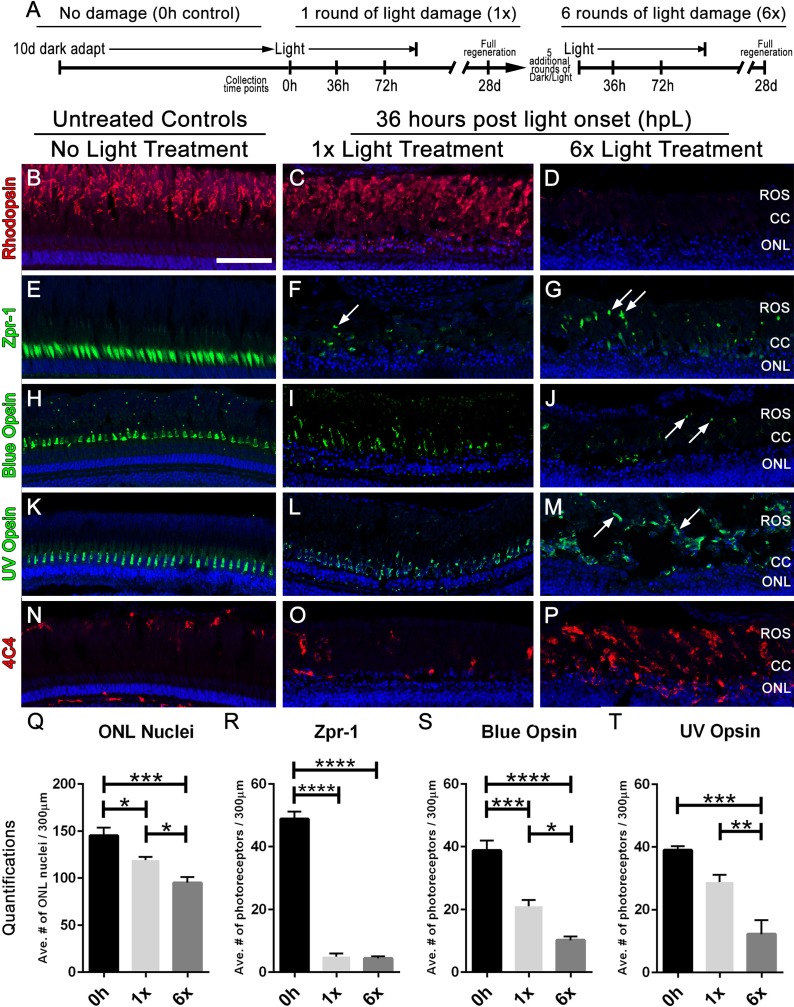
Multiple rounds of light treatment leads to greater photoreceptor loss at 36 h of light treatment.(A) Experimental design used for multiple rounds of light treatment. (B–P) Retinal sections collected at 36 hpL immunolabeled with anti-rhodopsin, Zpr-1, anti-blue opsin, anti-UV opsin, and 4C4 to show the varying amounts of damage to photoreceptors in untreated control (No Light Treatment), experimental control (1×Light Treatment), and experimental retinas (1×Light Treatment). Nuclei are stained blue with TO-PRO-3. (B–D) Rod photoreceptor outer segments are immunolabeled with anti-rhodopsin (red). (E–G) Red-green double cones are immunolabeled with Zpr-1 (green). (H–J) Long single cones are immunolabeled with anti-blue opsin (green). (K–M) Short single cones are immunolabeled with anti-UV opsin (green). (N–P) Microglia/macrophages are immunolabeled with 4C4 (red). In the images taken after six rounds of light treatment, arrows point to individual cone opsins in the large debris field. (Q–T) Quantification of average numbers of photoreceptors in untreated (0h), control (1×) and experimental (1×) groups (n = 5 per group) counted over a linear distance of 300 µm on the central dorsal retina. Asterisks indicates significant differences between groups (four asterisks p < 0.0001; three asterisks p < 0.0003; two asterisks p < 0.006; one asterisk p < 0.02). Scale bar represents 25 μm.